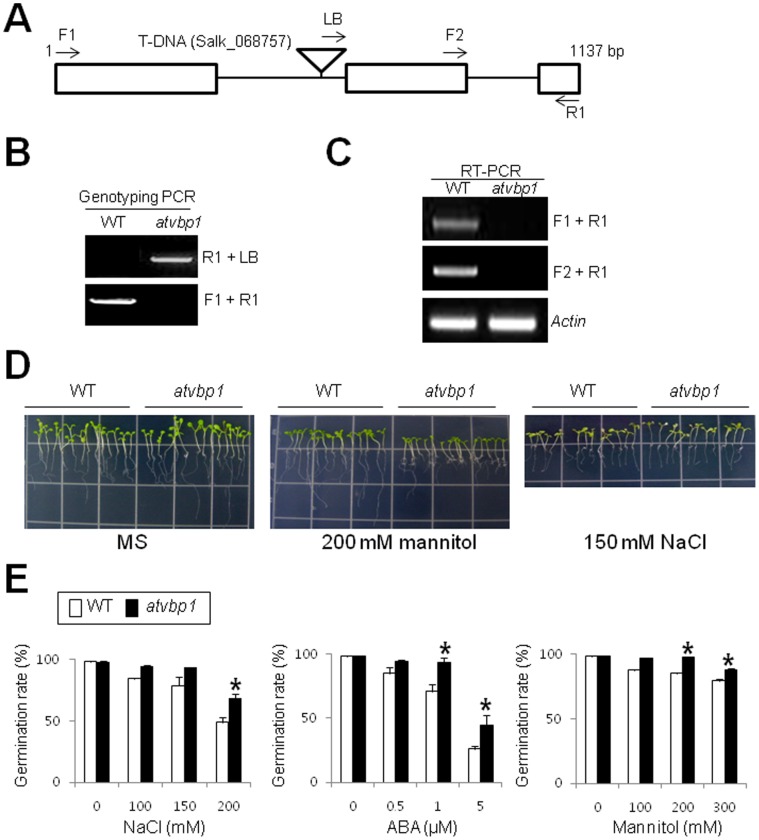
Identification and phenotypic characterization of atvbp1 mutant plants.(A) Schematic structure of the atvbp1 allele with the T-DNA insertion. The triangle indicates the T-DNA, white bars indicate coding regions, and the solid line represents introns. Gene-specific (F1, F2, and R1) and T-DNA specific (LB) primers used in genotyping and RT-PCR are indicated with arrows. (B) Genotyping PCR of the atvbp1 loss-of-function mutant plant. The T-DNA-specific and gene-specific primer sets used for genomic PCR are shown at right of the agarose gel. (C) RT-PCR analysis of AtVBP1 in the wild-type and atvbp1 plants. Two primer sets for RT-PCR are indicated at right on the agarose gel. Actin transcript levels were used as loading controls. Primers used in genotyping PCR and RT-PCR are listed in Table S1 in File S1. (D) Five-d-old seedlings of the wild-type and atvbp1 plants were transferred to MS medium containing 2% (w/v) sucrose and 0.8% (w/v) phytoagar supplemented with either mannitol (200 mM) or NaCl (150 mM) and incubated under short day conditions in a growth chamber for 5 days. (E) Seed germination percentage of the indicated lines grown on different concentrations of NaCl, mannitol, or ABA, was recorded at 4 d after the end of stratification. Data show the mean ± SD of three replicates. At least 100 seeds per line were measured in each replicate. Asterisks indicate the significance of the difference from the values between the wild-type and atvbp1 plants determined by Student’s t test (*0.01 ≤ P<0.05, **P<0.01).